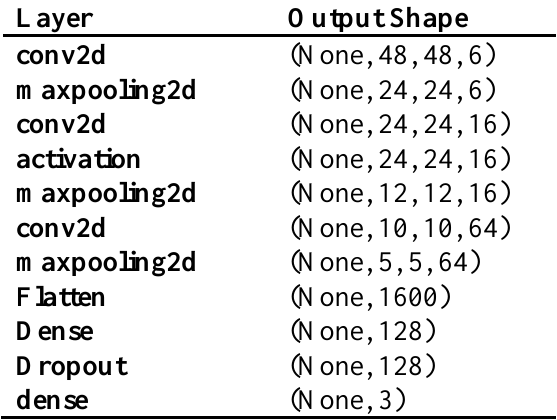
Figure 2. Model architecture